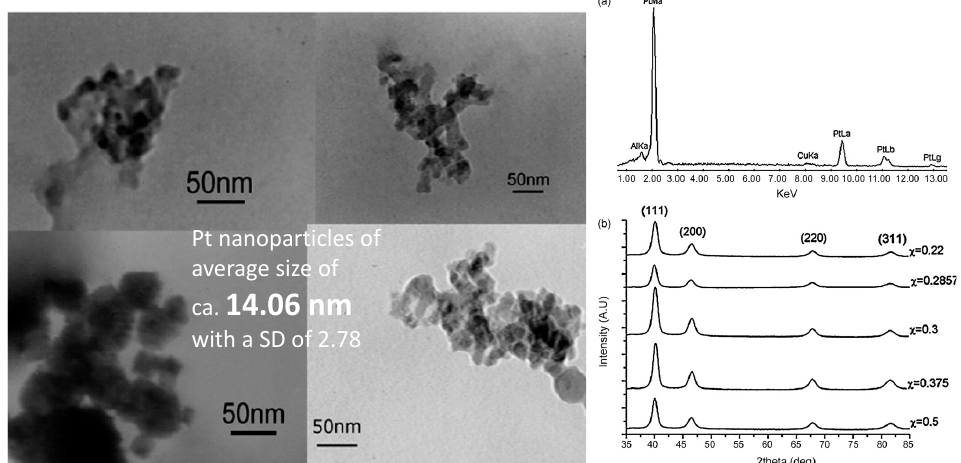
The workers found that (i) ultrasound had the principal role in causing cavitation in the